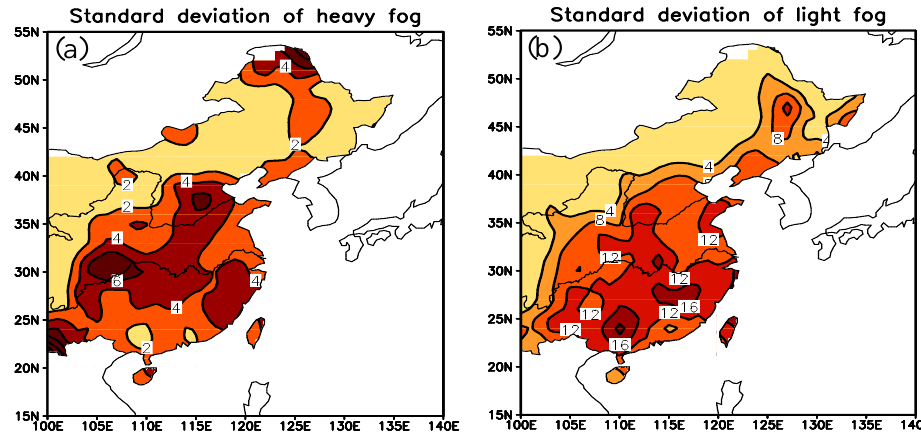
Figure 3. Standard deviation of winter fog days in eastern China during 1954–2007, respectively for ( a ) heavy fog and ( b ) light fog (unit: day).